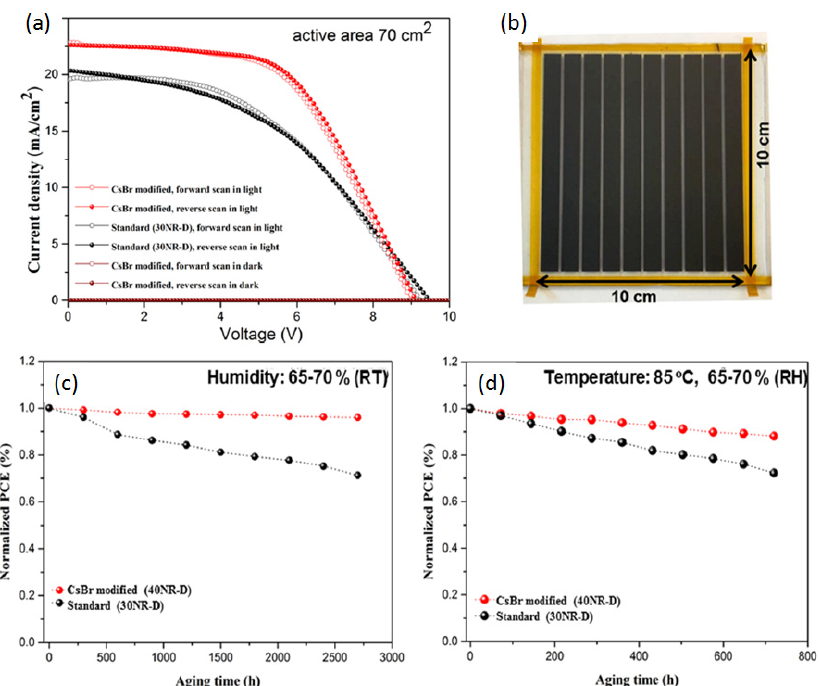
Figure 29 . ( a ) J–V traces of unmodified and CsBr modified large-area (70 cm 2 ) C-PSCs, recorded under 1 sun illumination and in the dark. ( b ) Photograph of the printed CsBr C-PSC module. ( c ) Normalized PCE decay as a function of time, performed under an ambient atmosphere (65–70% RH) at room temperature (RT) without sealing. ( d ) Normalized PCE decay rate at 85 °C under an ambient air for unencapsulated C-PSCs [105]. (Reprinted with permission from Ref. [105], Kavya S.